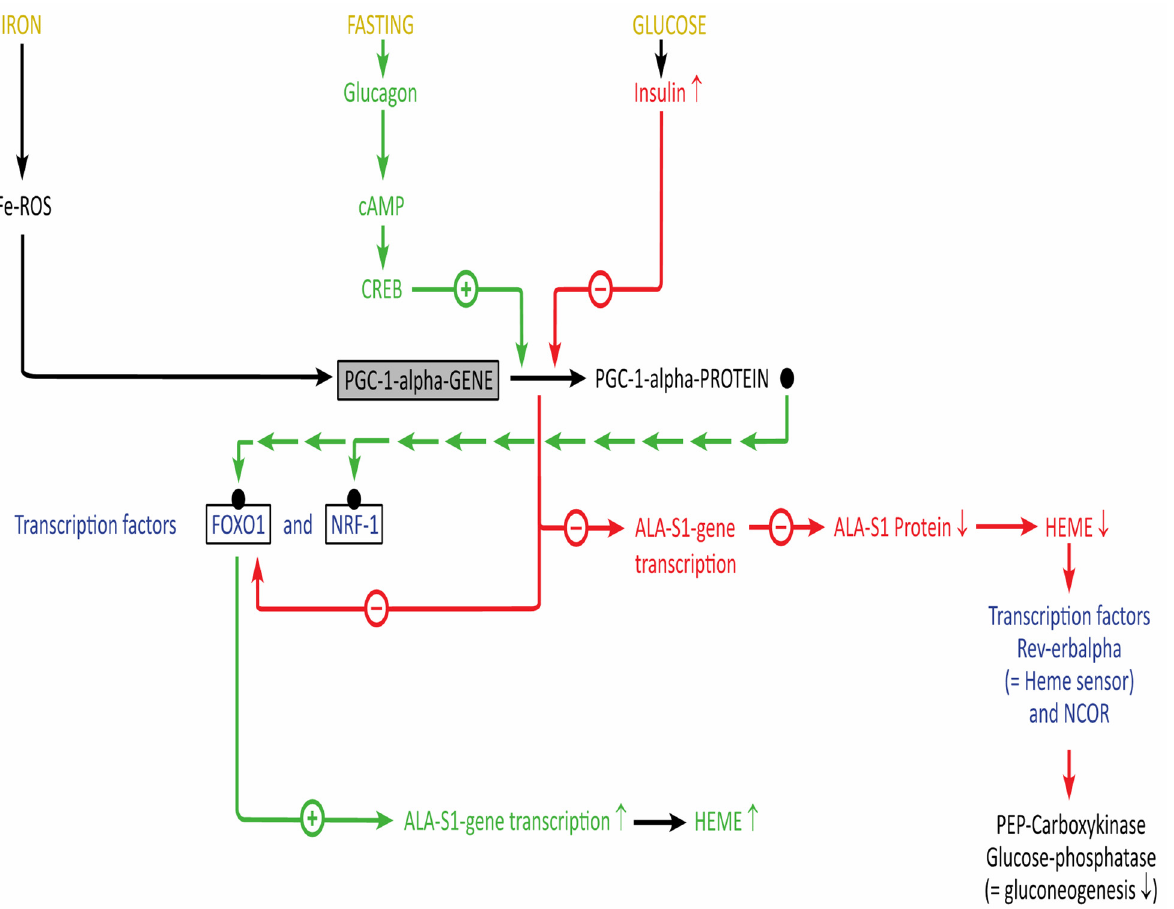
Figure 5. PGC-1-Alpha as a meeting point for the regulation of heme biosynthesis by fasting, glucose and iron (see text for details). Arrow up = increase, arrow down = decrease.